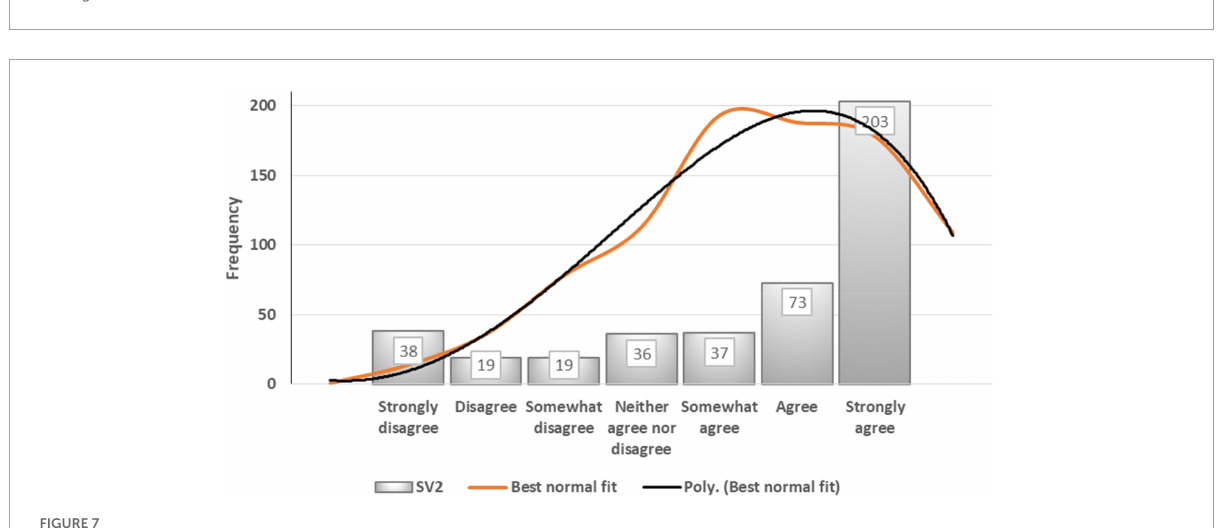
FIGURE6 Histogram of SV2 (%).